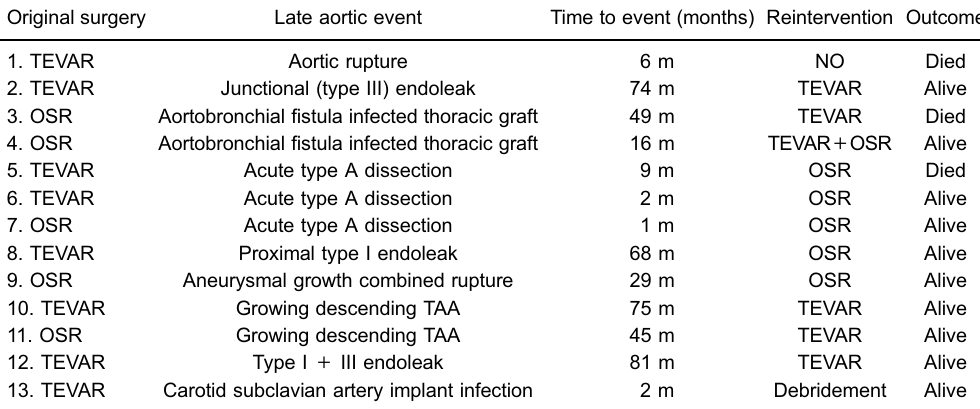
Table 3. Late treatment failures and outcomes in 13 patients with type-B aortic dissection. Original